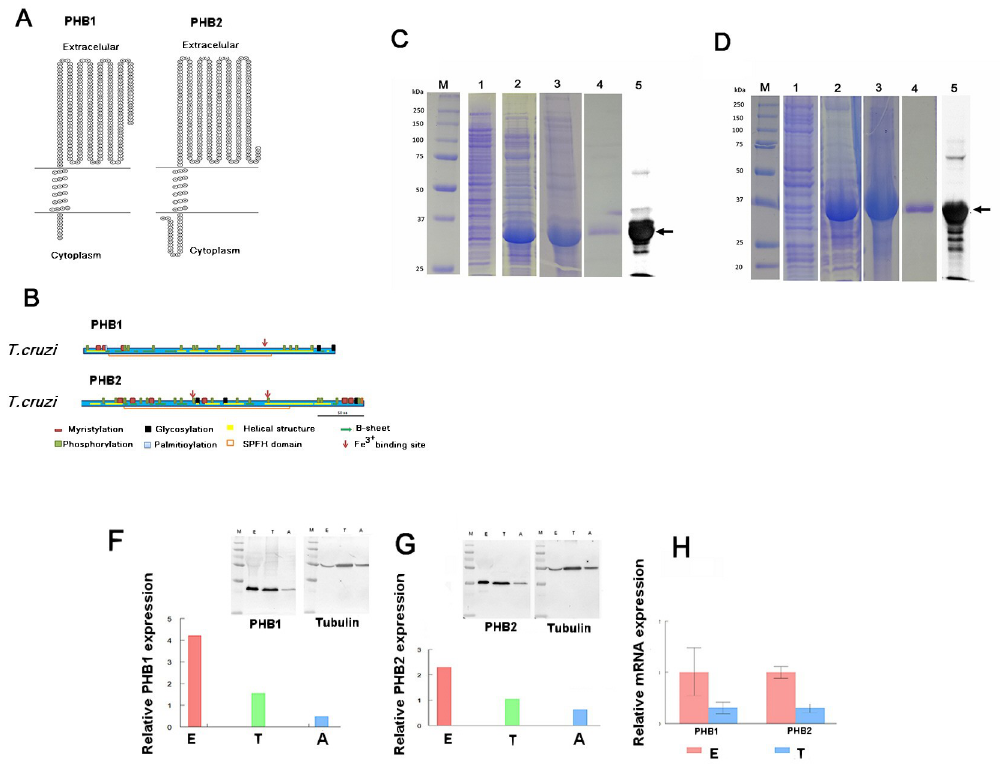
Fig 1. Bioinformatic predictions for PHBs. (A) Topological model of PHB1 and PHB2 from T . cruzi . Both proteins have a transmembrane helix that crosses the lipid bilayer, with their N-terminal domain in the cytosol and their C-terminal in the extracellular space. (B) Topology predictions were performed using CCTOP (http://cctop.enzim.ttk.mta.hu/) and TOPO2 transmembrane protein display software (http://www.sacs.ucsf.edu/cgi-bin/open-topo2.py). Prediction of the secondary structure, post-translational modifications, SPFH motif and Fe 3+ binding sites for PHB1 and PHB2. Expression of T . cruzi PHB1 (C) and PHB2 (D) in bacteria, isolation and purification: 1: total proteins of E . coli transformed with the recombinant plasmids with the phb gene without IPTG induction; 2: protein profile after induction with IPTG: 3: sample obtained from solubilized inclusion bodies; 4: sample after purification from SDS-PAGE, 5: recognition by Western blot with the primary antibody against the His-tag. Relative expression of PHB1 (F) and PHB2 (G) in the three different stages of the T . cruzi DM28c strain. Calculations were made by measuring the intensity of the bands obtained in the Western Blot assays (E epimastigote forms; T, trypomastigote forms and A amastigote forms). Lanes: M: All Blue molecular weight marker (Bio-Rad); E: total epimastigote proteins; T: total trypomastigote proteins; A: total amastigote proteins. (H) Relative mRNA quantification of the expression of the phb1 and phb2 genes by RT-qPCR in epimastigotes (E) and blood stream trypomastigotes (T). Expression levels were normalized with the gapdh expression for each stage.